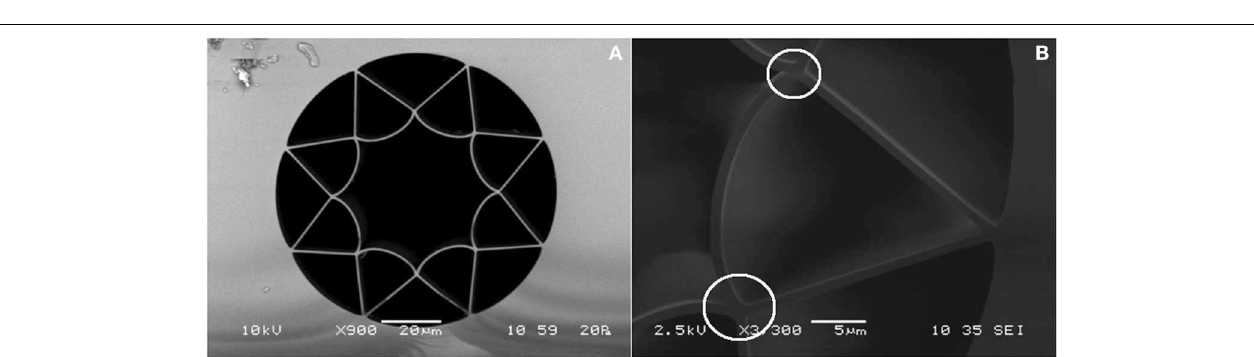
Frontiers in Physics |